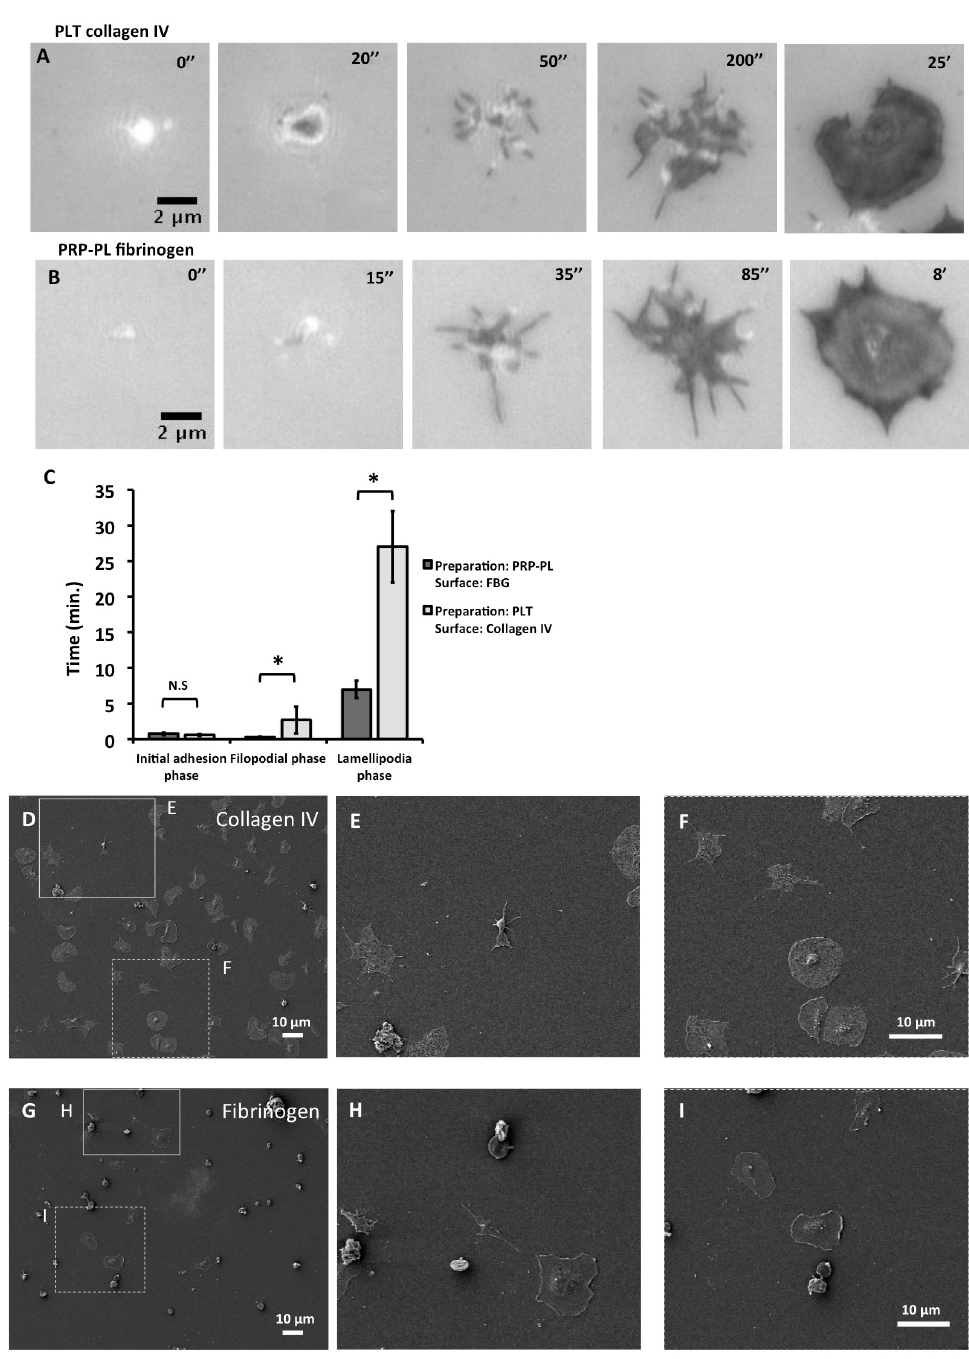
Figure 7. Use of IRM and SEM to image platelet dynamics on collagen IV and fibrinogen. ( A ) IRM (100X) of a platelet (PLT) spreading on collagen IV; (left to right) filopodia tapping and fluctuations (0’’, 50’’), filopodia spreading (50’’, 200’’), lamellipodial protrusion (200’’), to the final, spread shape (25’). Scale bar: 10 μm. ( B ) IRM (100X) of a platelet (PRP-PL) spreading on fibrinogen; (left to right) filopodia tapping and fluctuations (0’’, 35’’), filopodia spreading (35’’, 85’’), lamellipodial protrusion (85’’) to the final, spread shape (8’). Scale bar: 10 μm. ( C ) Dynamics of platelet spreading. Graph showing the length of each of the phases described in ( A ) and ( B ). Wilcoxon rank sum test was used. *p-value < 0.01, N platelets collagen IV=40, N platelets fibrinogen =40. Error bars show Standard Error. ( D ) SEM image (1.00 K X) of PLT on collagen IV. Scale bar: 10 μm. ( E ) SEM image (1.00 K X) of PLT on collagen IV, showing a filopodia spread platelet. ( F ) SEM image (1.00 X K) of PLT on collagen IV, showing a fully spread platelet ( G ) SEM image (1.00 K X) of PRP-PL on fibrinogen. Scale bar: 10 μm. ( H ) SEM image (1.00 K X) of PRP-PL on fibrinogen, showing a filopodia spread platelet. ( I ) SEM image (1.00 X K) of PRP-PL on fibrinogen, showing a fully spread platelet. Scale bar: 10